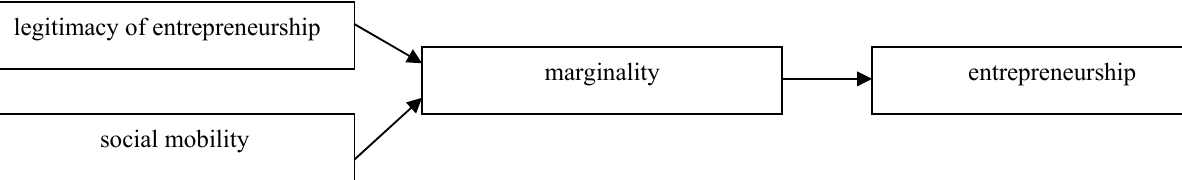
Figure 3: Diagram showing the relationship of marginality and entrepreneurship Studies show that marginal entrepreneurship is more likely when entrepreneurship is not valid (Hoselitz, Kriesberg, Lipset as cited by Wilken, 1979:12). Since entrepreneurship is undesirable for ‘unmarginalized’ members of society, only marginals are ‘forced’ to it. Second, relative